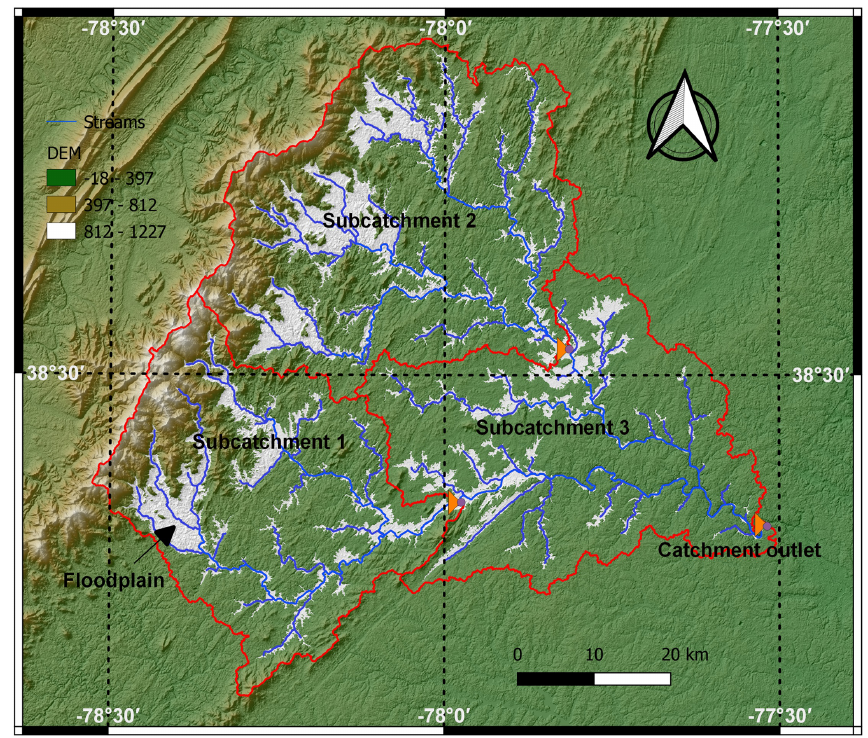
Figure 3. Rappahannock River basin at Fredericksburg, Virginia, USA (map was generated through SWAT + plugin in QGIS software using USGS EarthExplorer’s Shuttle Radar Topography Mission DEM